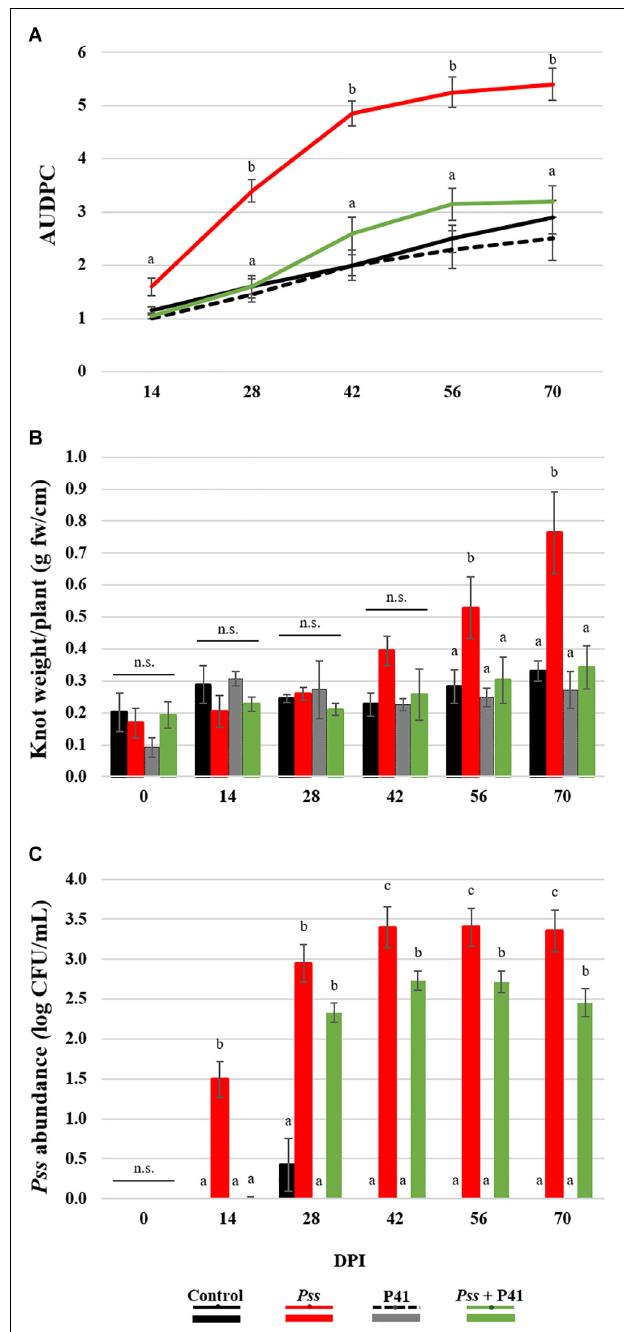
FIGURE 4 | Effect of Bacillus amyloliquefaciens (P41 isolate) on olive knot disease progression determined by in planta assays. The ability to suppress disease development was evaluated by OK disease severity curves (AUDPC) (A) , knot fresh weight per plant (B) and Pseudomonas savastanoi pv. savastanoi ( Pss ) population density on the inoculated area of olive plants (C) , determined on olive plantlets inoculated with the pathogen ( Pss ), with both antagonist and pathogen ( Pss + P41), with the antagonist (P41) and with LB medium (negative control). Data is presented as means ± SE ( n = 10 for severity; n = 5 for the knots weight and Pss density). Statistically significant ( p < 0.05) differences between the four treatments, in each day post-inoculation (DPI), are indicated by different letters